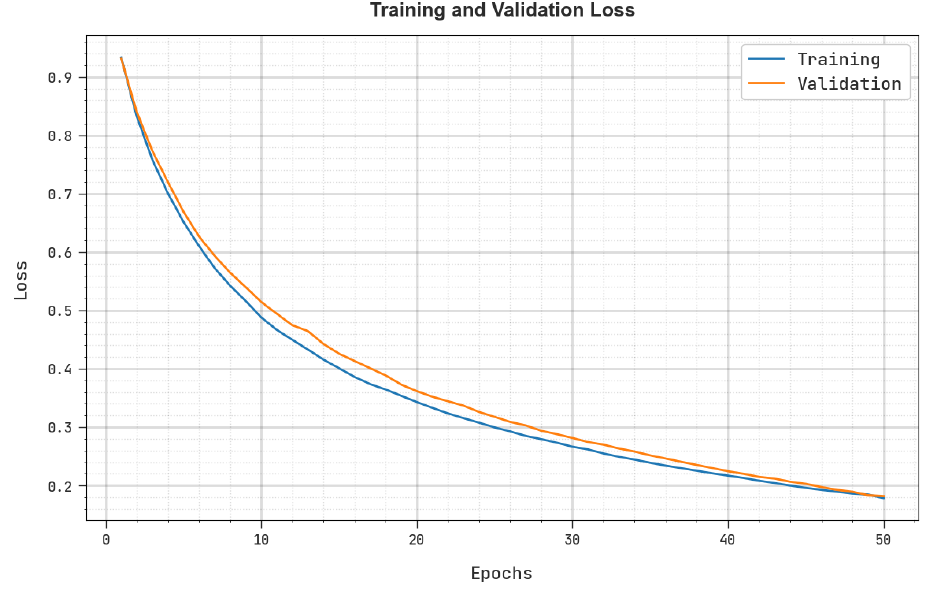
Figure 11. TRL and VLL analysis of the RFER-EADL algorithm.